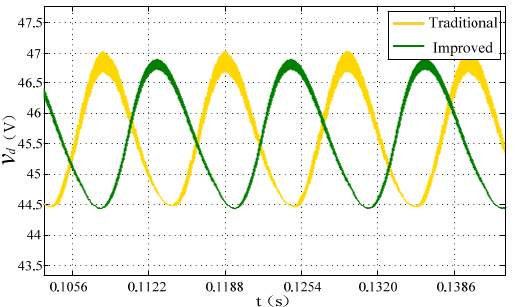
Figure 9. Capacitor voltage waveforms under traditional modulation strategy and improved modulation strategy when φ = φ ’ = 0 ° .